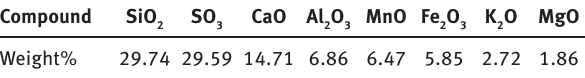
Table 1: The main constituents of EMR used in this study. Compound